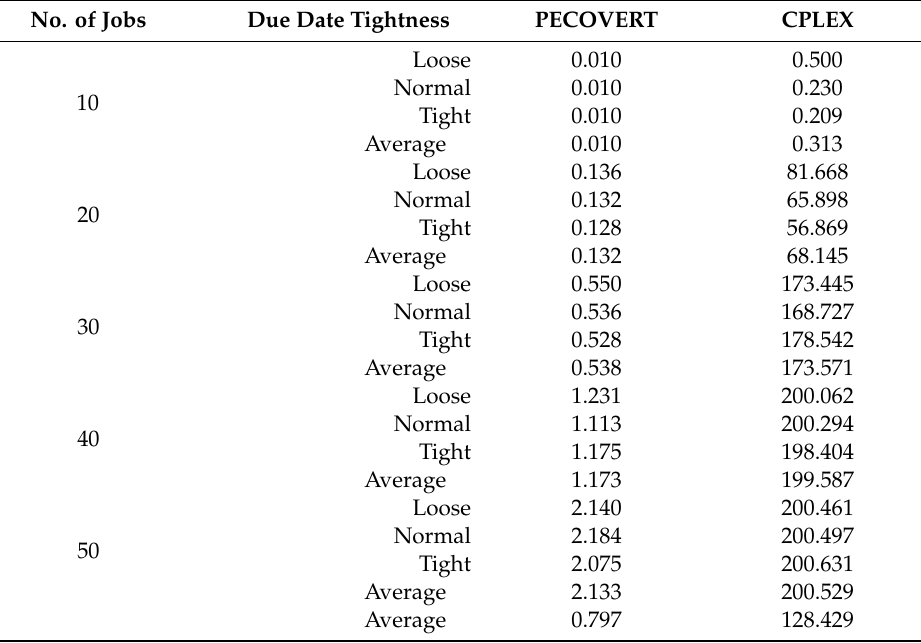
Table 6. Results of the computational